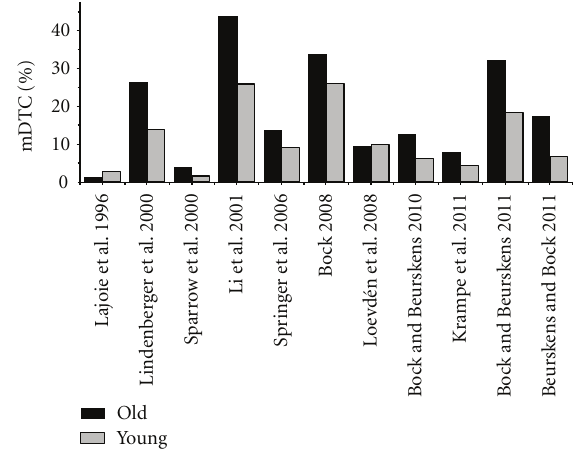
Figure 1: Illustration of mean dual-task costs from di ff erent studies evaluating age-related deficits in dual-task walking. Data is calculated from mean values in walking performance and mean values in the secondary tasks used in the studies indicated. Standard errors are not displayed because the data from each individual subject could not be